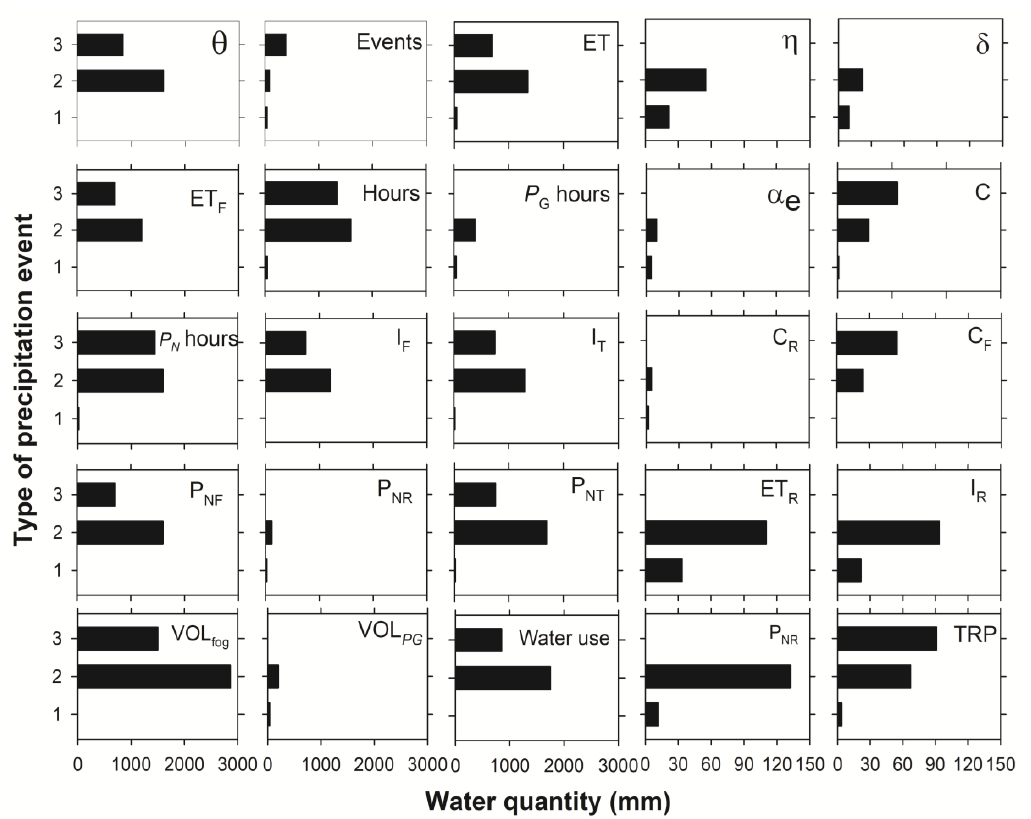
Figure 2. Values of water used (θ; mm), total number of precipitation events (Events), total evapotranspiration (ET; mm), water absorbed (η; mm), water stored (δ; mm), fog evapotranspiration (ET F ; mm), total number of hours of precipitation (Hours), total number of hours of gross precipitation (Hours P G ), water for extra storage (α e ; mm), total condensation (C; mm), total number of hours of net precipitation (Hours P N ; mm), fog interception (I F ; mm), total interception (I T ; mm), rainfall condensation (C R ; mm), fog condensation (C F ; mm), net precipitation generated by fog ( P NF ; mm), net precipitation generated by rainfall ( P NR ; mm), total net precipitation ( P NT ; mm), rain evapotranspiration (ET R ; mm), rain interception (I R ; mm), volume of fog (Vol fog ; mm), volume of gross precipitation (Vol P G ; mm), water consumed by the plant (Water use; mm), net precipitation generated by rainfall ( P NR ; mm), and total transpiration (TRP; mm). Data are given according to the type of precipitation event (1, 2, and 3; see details in